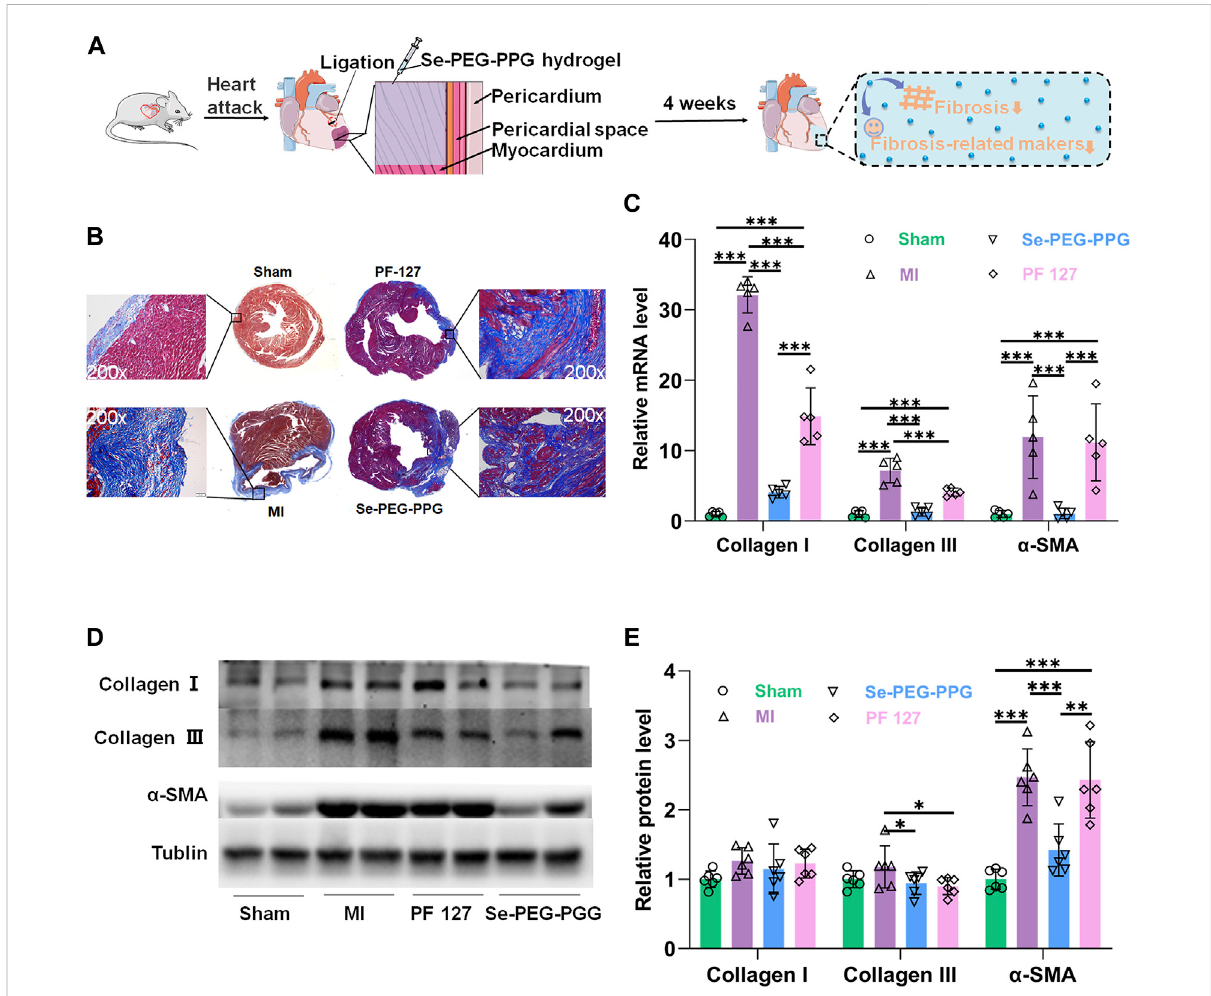
FIGURE 6 Poly (DH-Se/PEG/PPG urethane) attenuates cardiac fi brosis MI induced. (A) Schematic illustration of decreased fi brosis and fi brosis-related makers after injection of Se-PEG-PPG hydrogel; (B) Masson ’ s trichrome staining of heart was shown. Collagen fi bers were stained blue and myocardiumwasstainedred.Scalebar:10 mm; (C) RelativemRNAexpressionlevelsof α -SMA,Collagen Ⅰ andCollagen Ⅲ wereestimatedbyRT-PCR andnormalizedtothoseofGAPDH( n =5,*** p < 0.01); (D,E) Theproteinexpressionlevelof α -SMA,Collagen Ⅰ andCollagen Ⅲ inmousecardiac tissues ( n = 6, *** p <